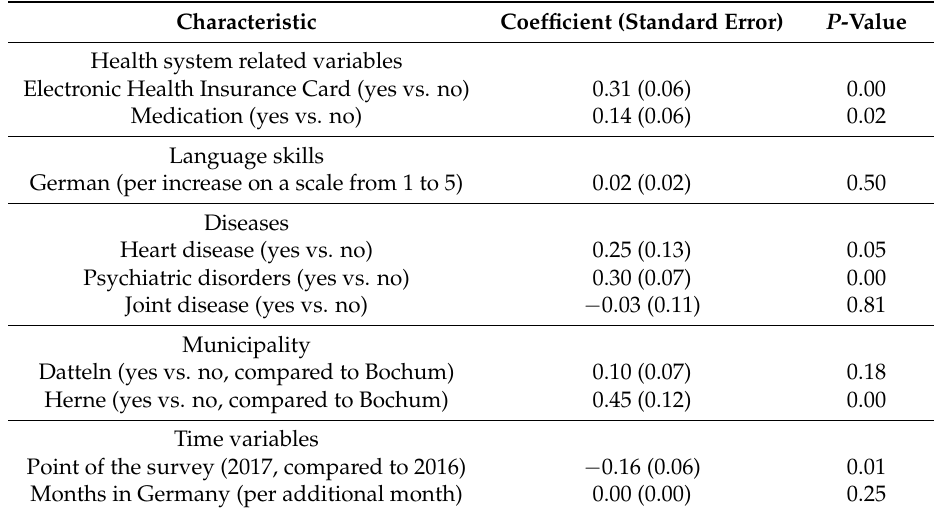
Table 2. Factors associated with the consultation rate of ambulant physicians per month among a sample of asylum seekers in Germany (with EHIC: n = 137, without EHIC: n = 216). Characteristic Coefficient (Standard Error) P